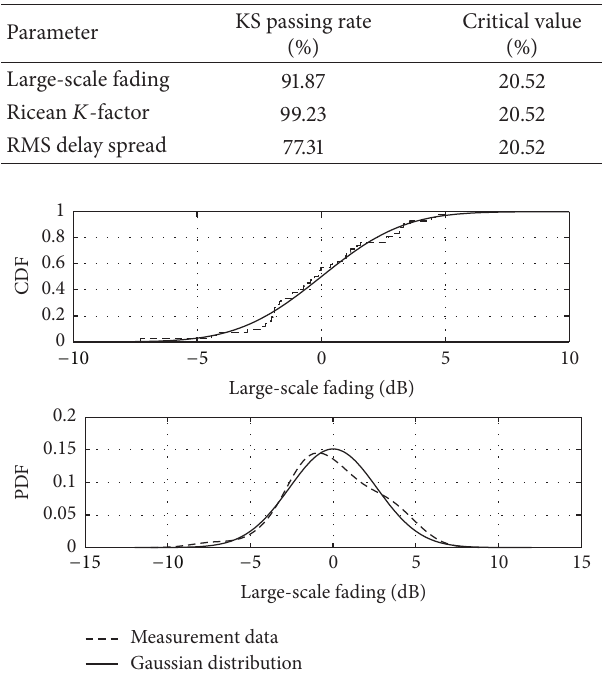
Figure9:CDFandPDFofthemeasuredlarge-scalefading,together with a Gaussian fit.